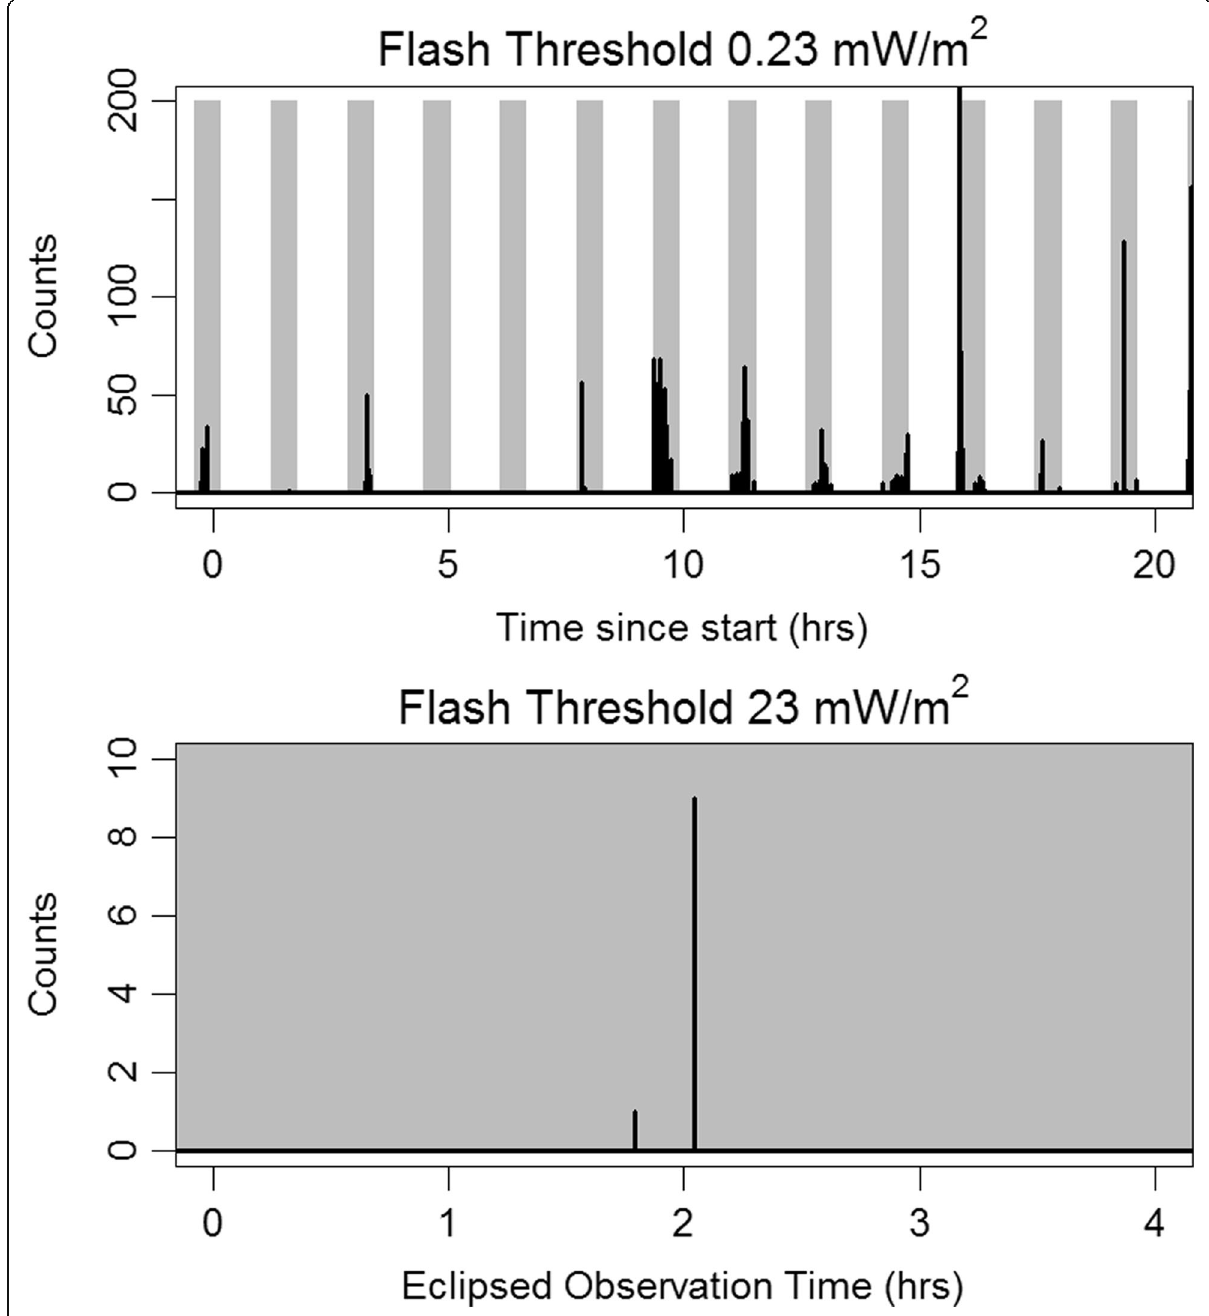
Fig. 11 Optical flashes recorded by one of the two photodiode detectors on the C/NOFS satellite (downloaded from https://cdaweb.sci.gsfc.nasa.gov/ index.html/). The top panel shows data for the lowest (most sensitive) threshold brightness — flashes are only detectable in the gray eclipse periods. The counts are the number of samples (~4000) per 0.5 s integration period that exceed a flux threshold, here 0.23 mW/m 2 — count rates are as high as a couple of hundreds. The bottom panel concatenates several eclipse periods together into an observation comparable in length with Hansell et al. ’ s (1995) telescopic Venus survey which detected seven flashes in about 4 h. With a 100 times higher threshold than the top panel, only a handful of counts are now obtained, and periods of 2 h or more exist with no counts at all (note that the instantaneous field of view of this sensor is only ~1000×2000